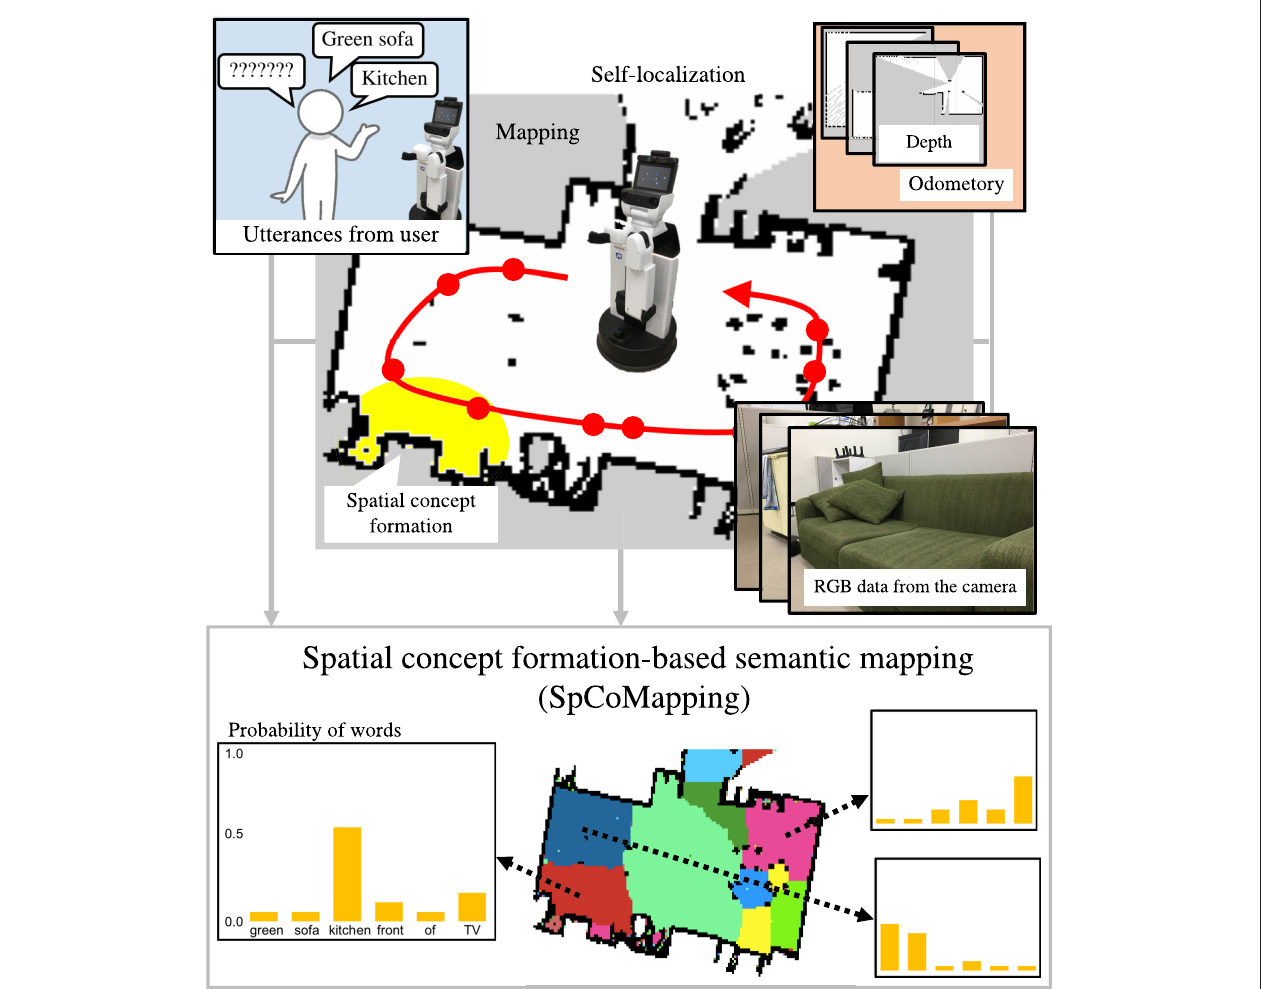
FIGURE 1 | Overview of SpCoMapping. The robot moves around in the environment to obtain RGB data, words, and self-position data. It then learns spatial concepts by integrating multimodal information with a Markov random field and generates a semantic